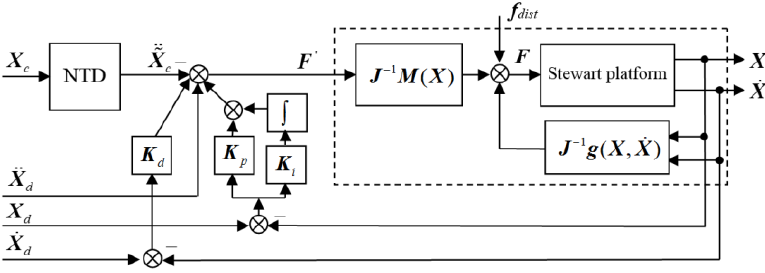
Figure 6 . Controller of the cable-driven parallel manipulator (CDPM) based Stewart platform.